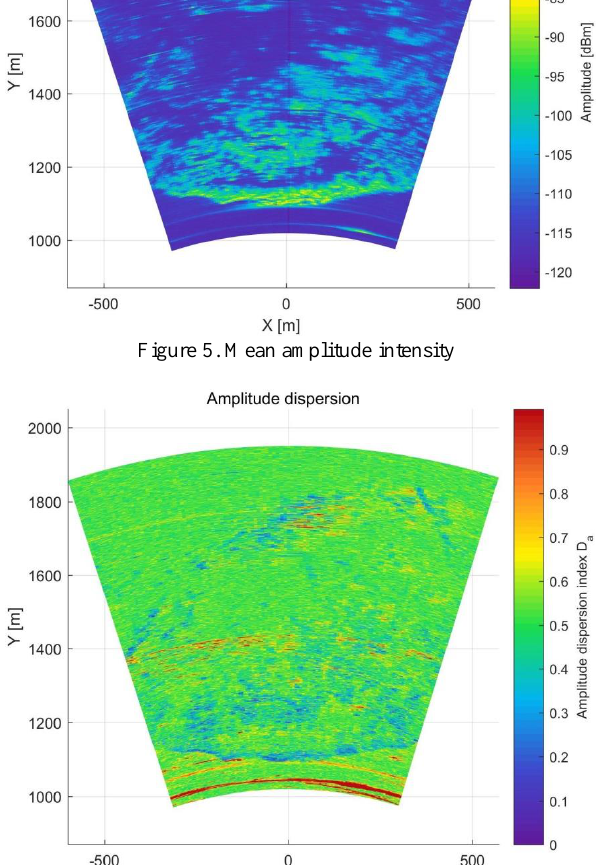
Figure 6. Amplitude dispersion